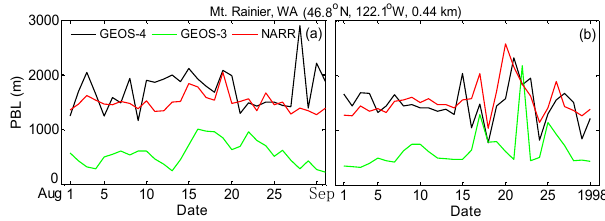
Figure 6. Monthly mean surface BC concentrations from June to December 1998 at (left) Mt. Rainier, WA (46.8°N, 122.1°W, 0.44 km) and (right) Three Sisters, OR (44.3°N, 122.0°W, 0.89 km). Red lines: IMPROVE observations; black lines: model driven by GEOS-4 data and with 8-day GFEDv2 emissions; green lines: model driven by GEOS-4 reanalysis data and with Duncan et al. [2003] interannual biomass burning emissions; blue lines: model driven by GEOS-3 reanalysis data and with Duncan et al. [2003] interannual biomass burning emissions.